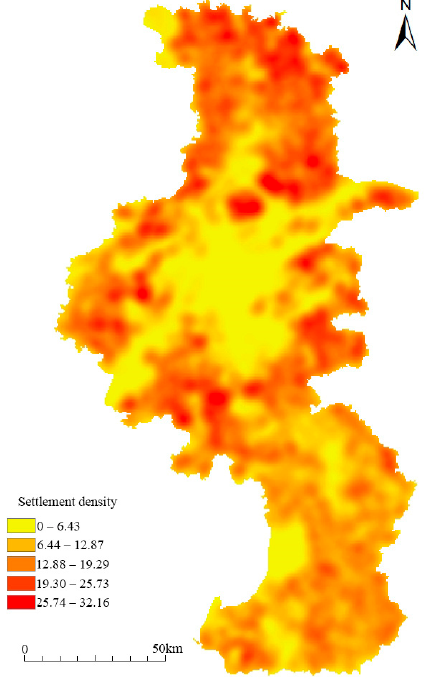
Figure 4. Density distribution of rural settlements in Nanjing.